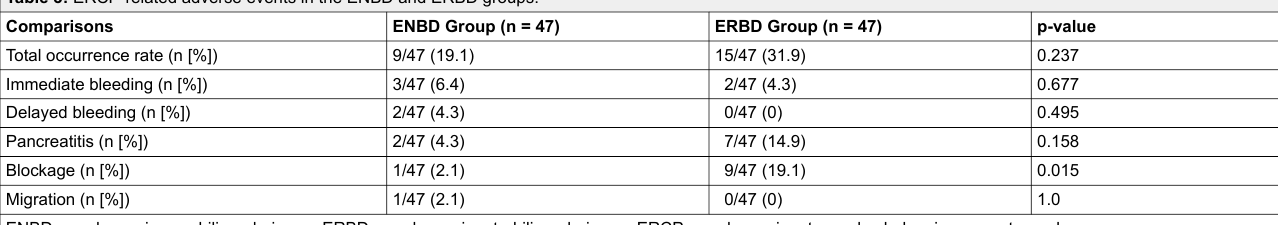
Table 3: ERCP-related adverse events in the ENBD and ERBD